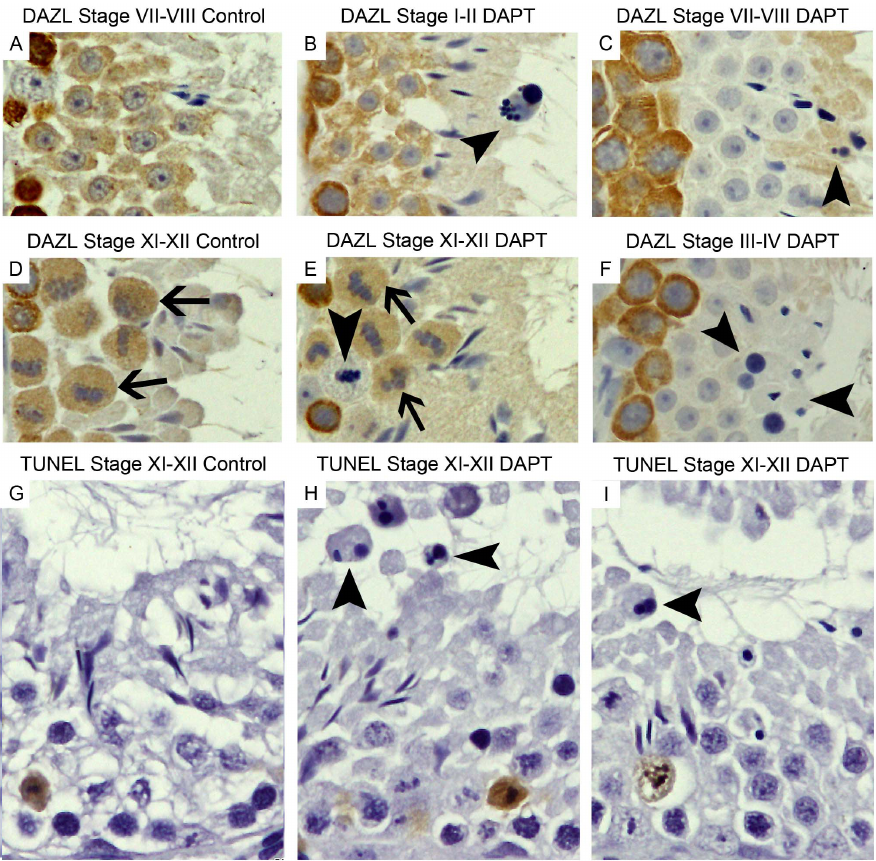
Figure 5. Abnormal germ cells loose identity. Positive staining in brown, counterstaining with haematoxylin (400x magnification). Germ cells of control mice stain with marker DAZL (A and D). Most abnormal germ cells of DAPT treated mice do not stain with marker DAZL (B, C, E and F). TUNEL staining of seminiferous tubules of control (G) and DAPT treated (H and I) mice. Abnormal germ cells are TUNEL negative. Arrow heads point abnormal germ cells. Arrows point normal dividing germ cells.